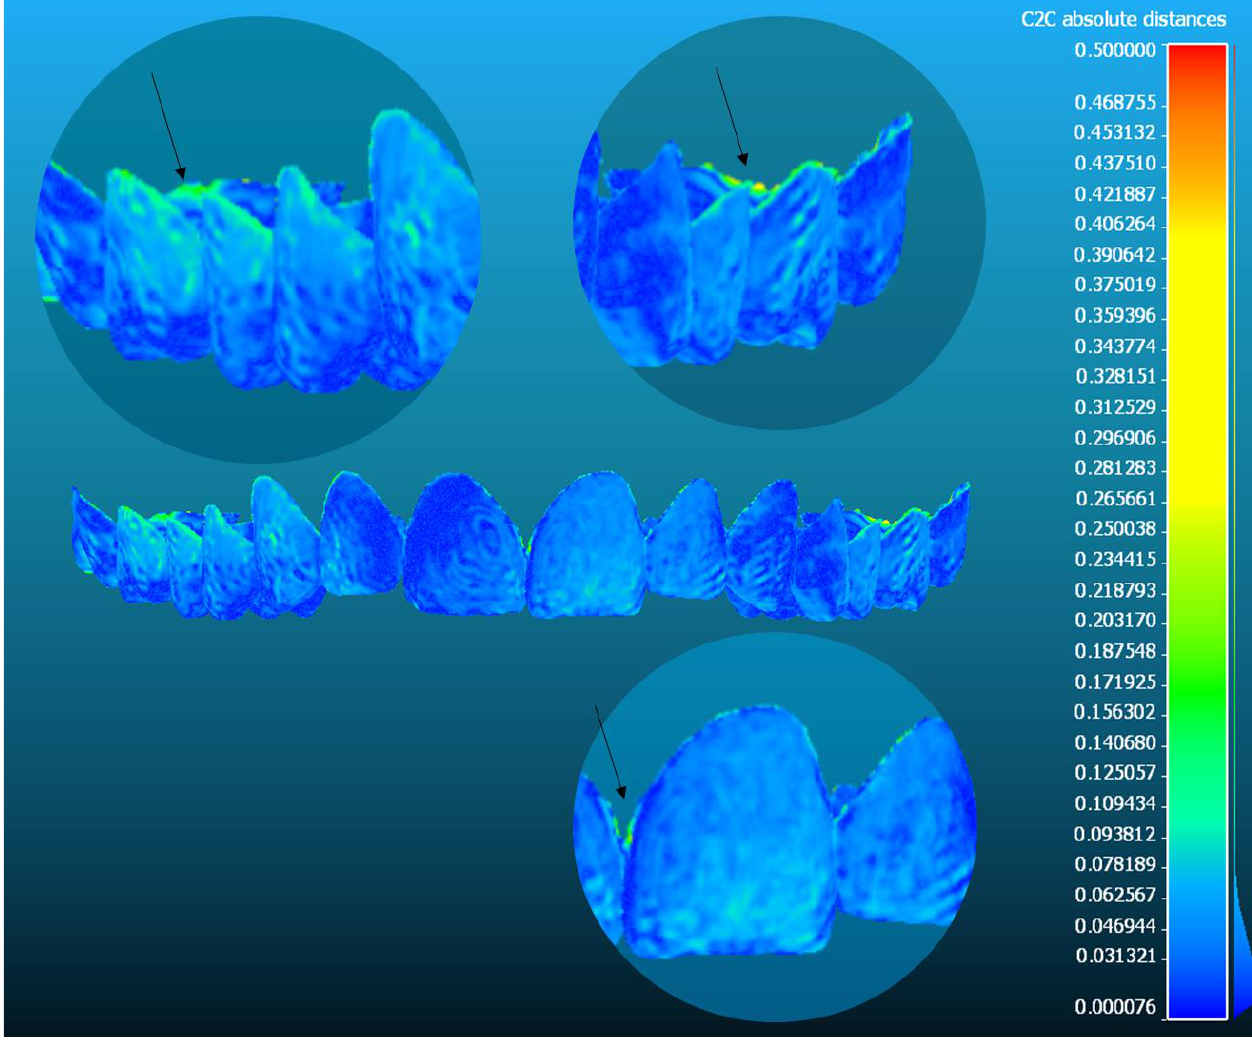
Figure 5. Colorimetric map generated by the 3D models ’ superimposition. The cumulative frequency of points with deviation below various thresholds for each pair of models was expressed in percentage with the mean value and standard deviation (Table 1).